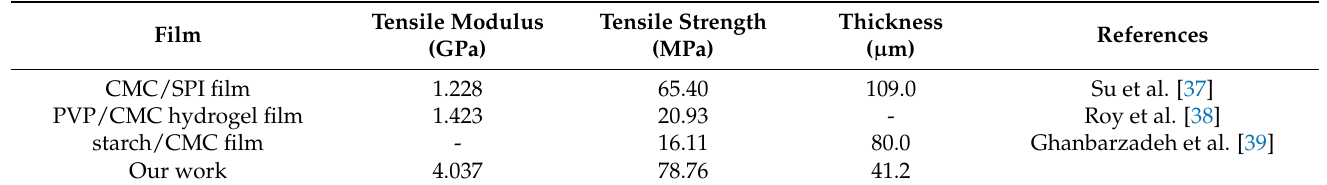
Table 4. Comparison of mechanical properties of the blend films with the other CMC